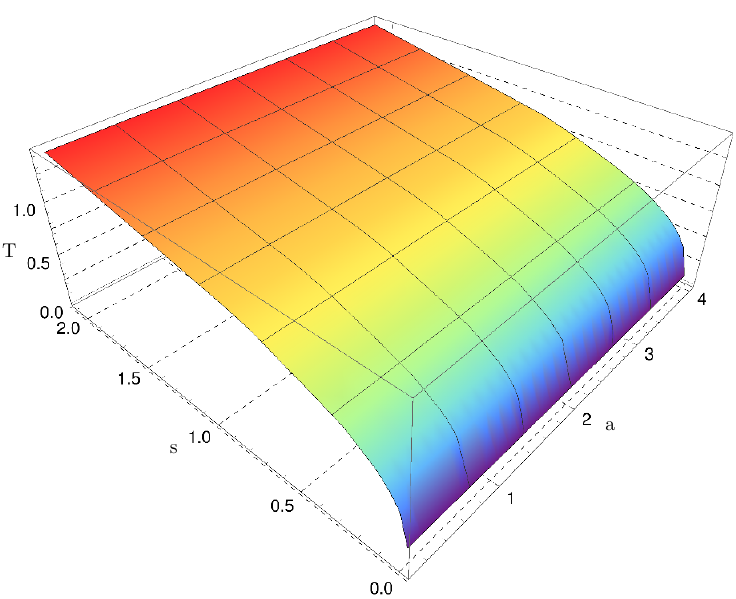
Figure 5 . The temperature of the anisotropic model as a function of the entropy density and the anisotropy parameter at (cid:12)xed non-conformal deformation (c=1). It is visible that T does not change at all with a , which in particular shows that the speci(cid:12)c heat C of the plasma does not change under the anisotropic